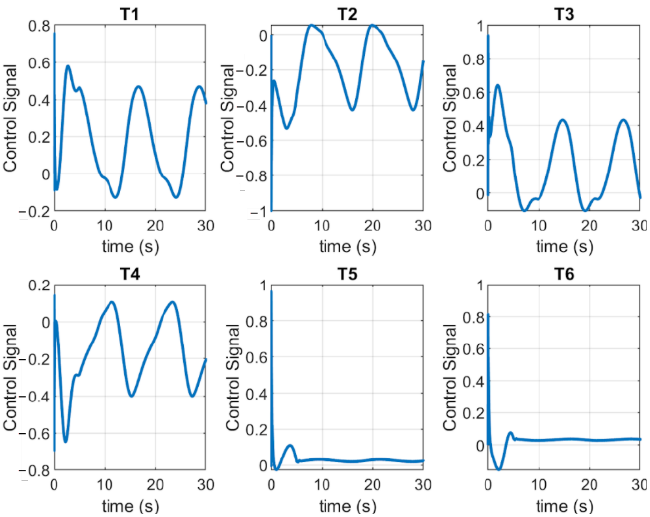
Figure 13. Control signal for each thruster when subject to ocean currents and 𝑡 𝑏 = 5 s .